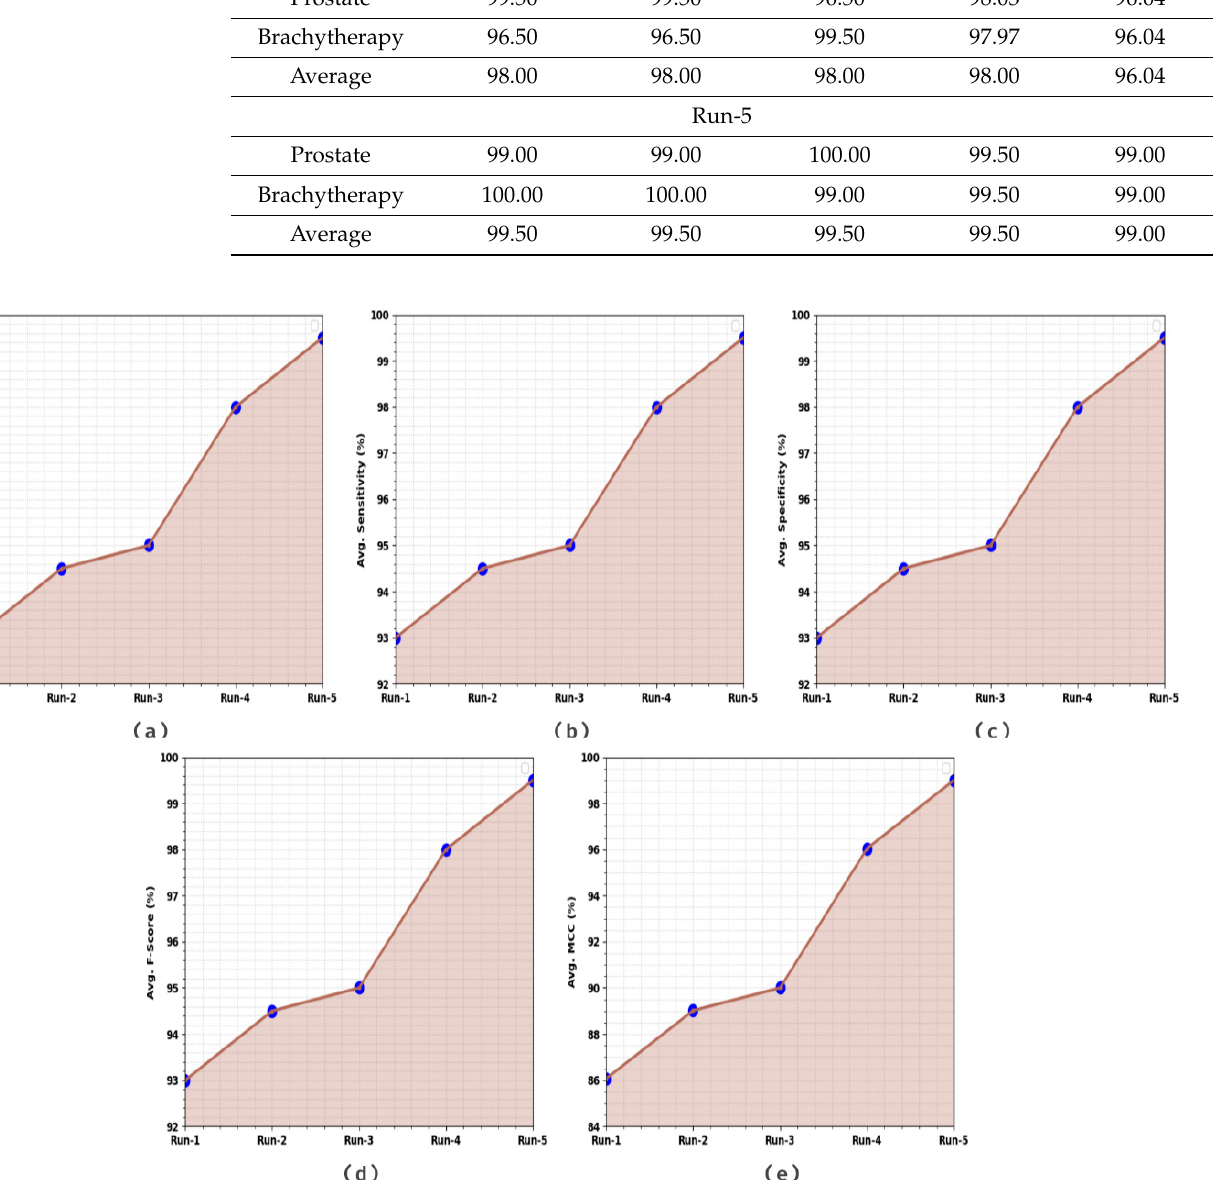
Figure 5. Average analysis of the AOADLB-P2C system: ( a ) Run-1, ( b ) Run-2, ( c ) Run-3, ( d ) Run-4, and ( e ) Run-5.